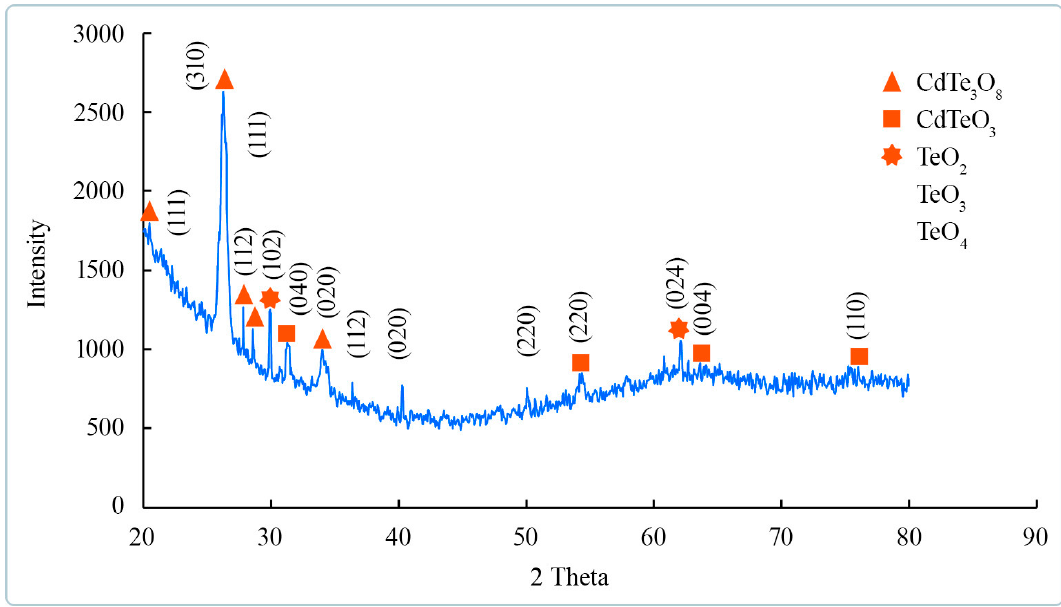
Figure 5. XRD spectrum of the Cd x Te y O z /CdS/ZnO heterostructure.